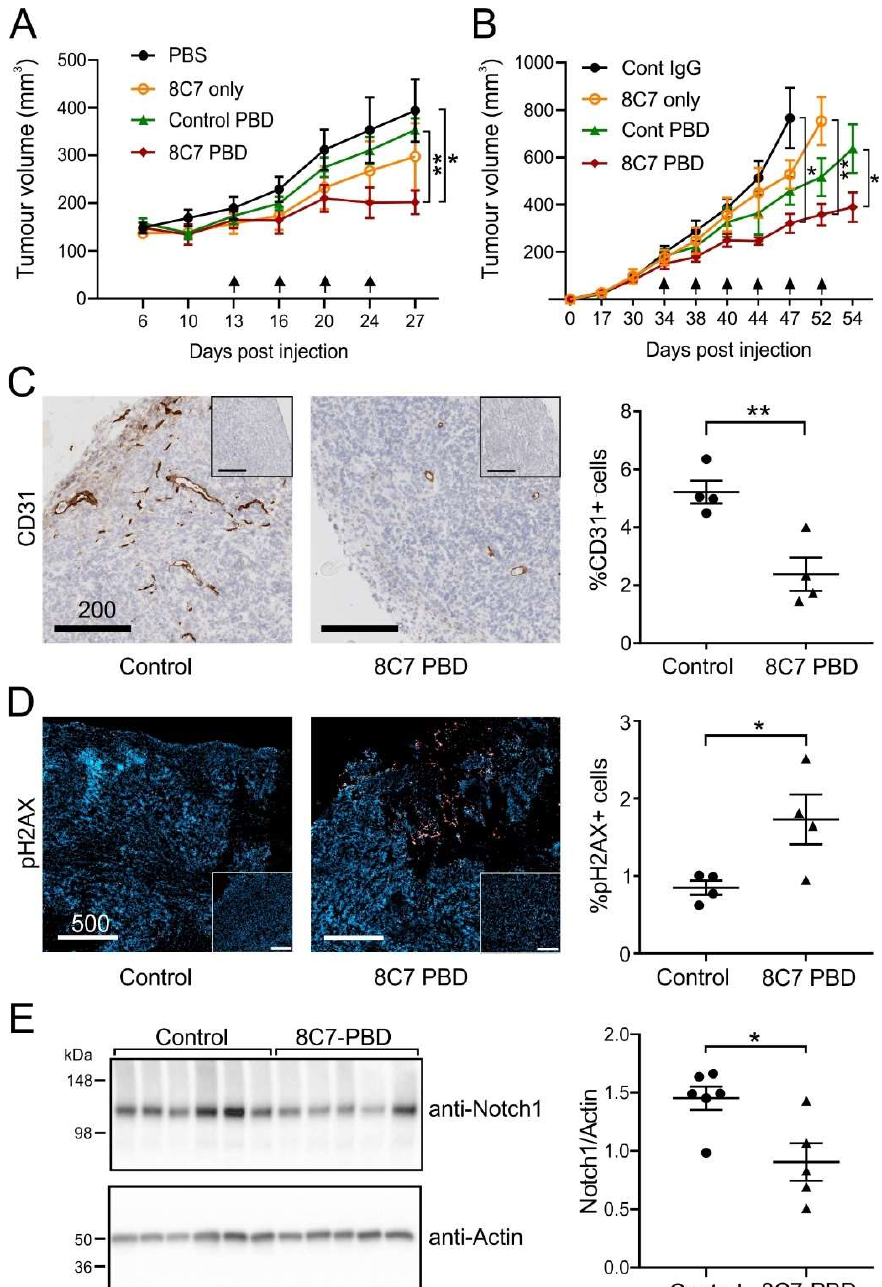
Figure 5. Treatment with 8C7-PBD inhibits tumour growth in mice. ( A ) Tumour volumes in mice bearing LIM1215 xenografts ( n = 6) treated with 8C7-PBD (0.5 mg/kg), control IgG-PBD (0.5 mg/kg), 8C7 only (10 mg/kg) or vehicle control (PBS) at the indicated times (arrows). ( B ) Mice bearing U251 glioma xenografts ( n = 5) were treated with 8C7-PBD, control IgG-PBD, control IgG (0.3 mg/kg) or 8C7 only (10 mg/kg) and tumour growth was measured. ( C , D ) LIM1215 tumours recovered from control- and 8C7-PBD-treated mice, and analysed via IHC staining of CD31 ( C , brown) and immunofluorescence staining of phospho-Histone H2AX ( D , red; nuclei, blue). Insets: secondary antibody-only controls. Representative zoomed images and quantitation of whole tumour sections are shown (scale bars in microns). ( E ) Tumour lysates were Western blotted for Notch 1, and actin was used as loading control. Graph shows quantitation of Notch1 expression relative to actin. All graphs show mean +/- SEM, * p < 0.05, ** p < 0.01.